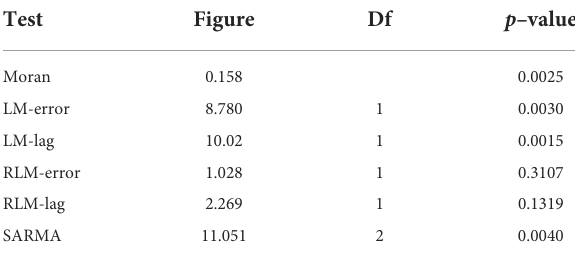
TABLE 1 Figures and tests for the identification of the